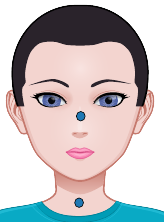
Figure 7. Cluster analysis on the distribution of TEWL returned only one cluster of statistically indistinguishable areas: neck and nose.